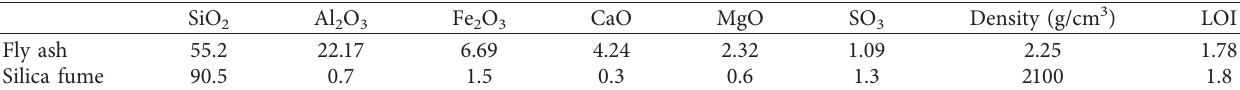
Table 2: Related parameters of mineral admixtures.